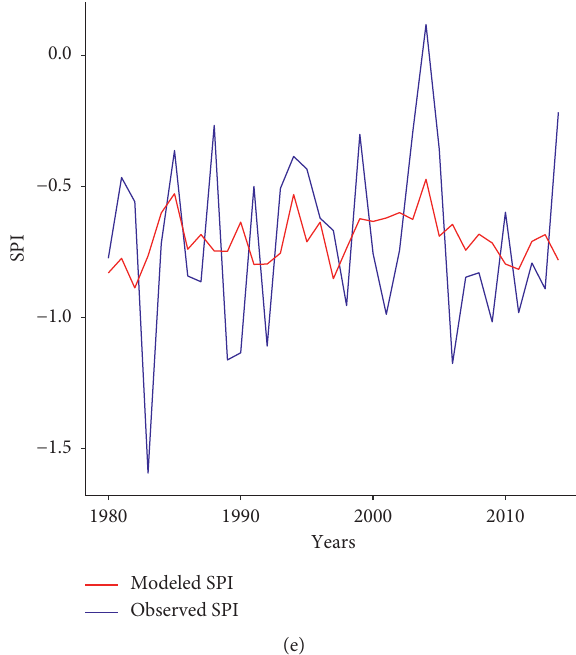
Figure 7: Comparison between modeled JFM SPI based on DJF climate indices versus observed JFM SPI for (a) Accra, (b) Ada, (c) Tema, (d) Saltpond, and (e) Takoradi meteorological stations at timescale of drought periods. The observed SPI is in blue and red is modeled.